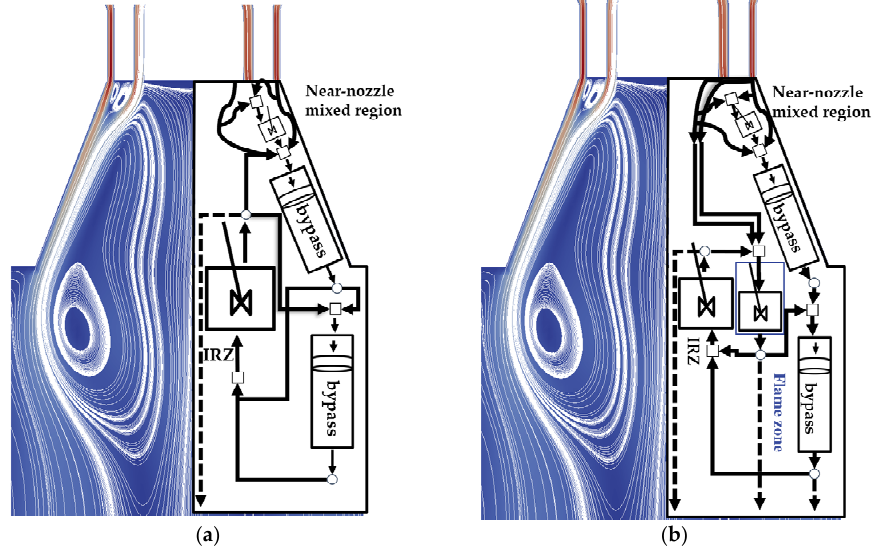
Figure 4. Magnification of the near-nozzle and CRN depiction: ( a ) isothermal case; ( b ) reactive case.